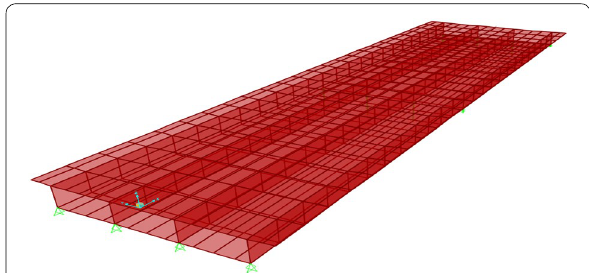
Fig. 2 Finite element model of a typical three-boxes bridge with L 30 m. =